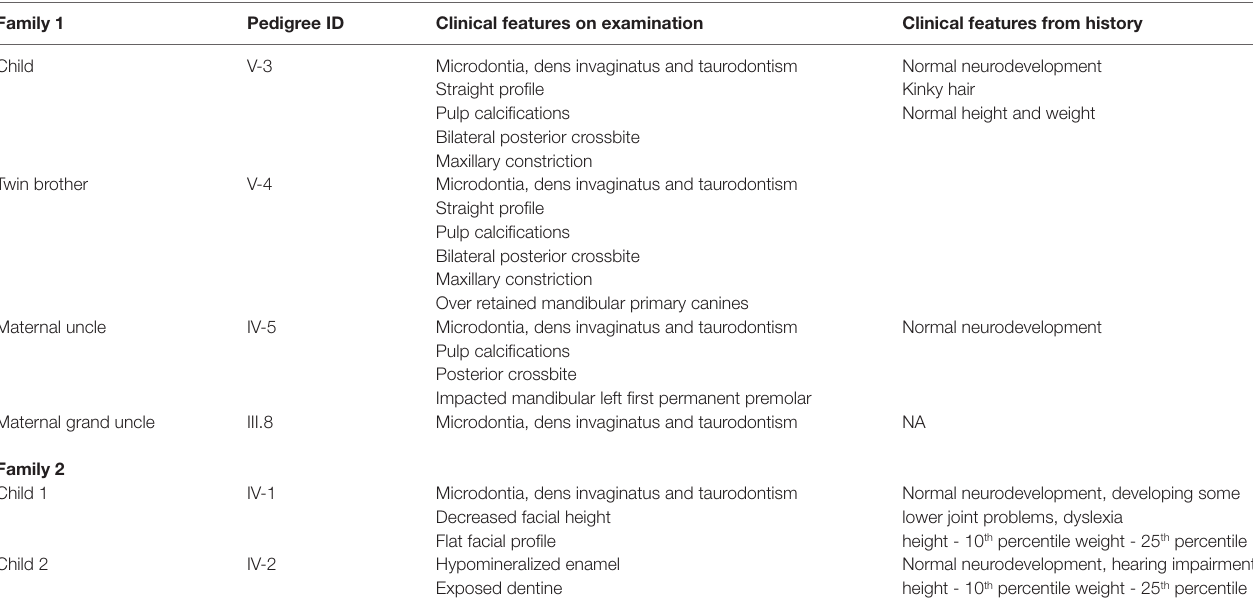
TABLE 1 | Clinical features of affected individuals in family 1 and